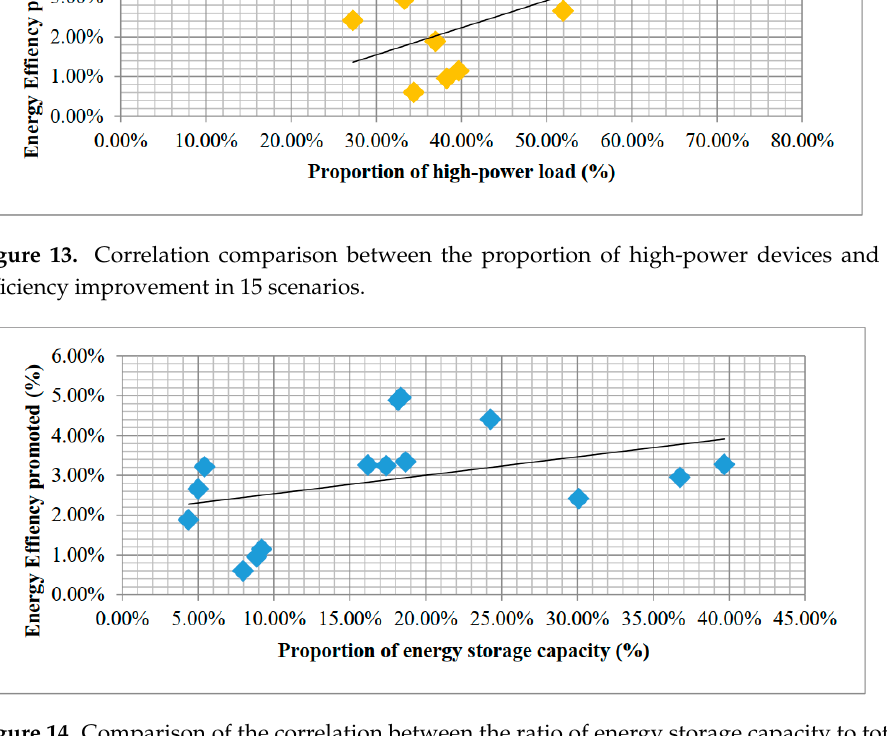
Figure 14. Comparison of the correlation between the ratio of energy storage capacity to total load and energy efficiency improvement in 15 scenarios.